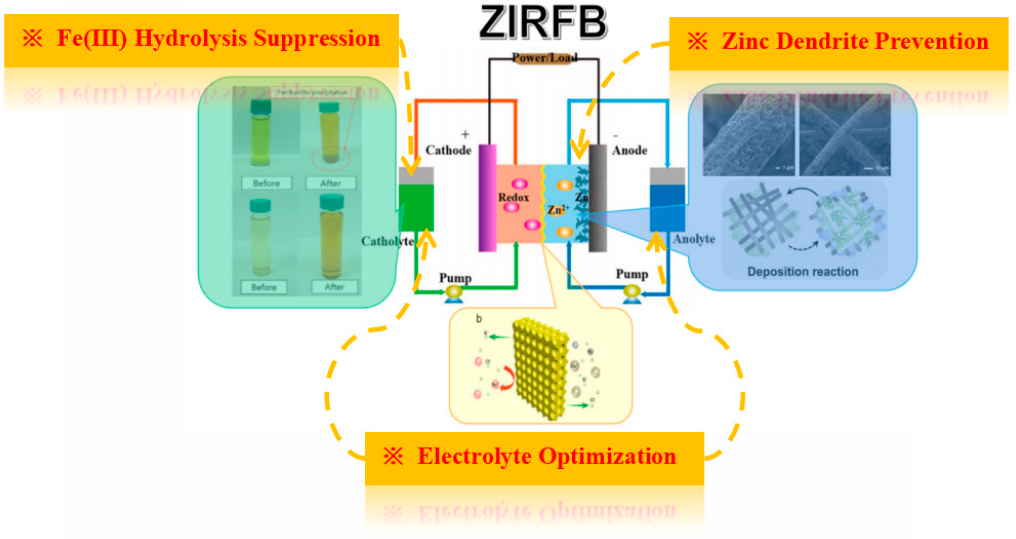
Figure 4. Several key problems in a ZIRFB. Reproduced with permission from [44].